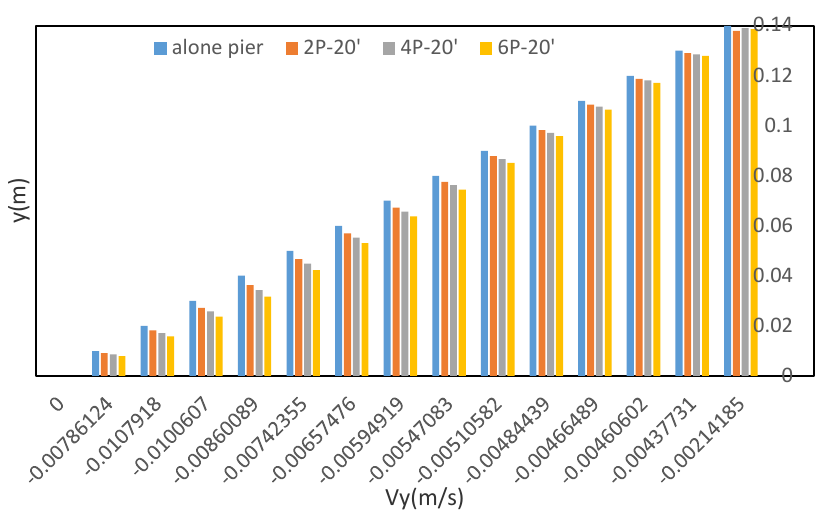
Fig 18. Comparison of the vertical velocity component for 𝛼 = 20˚ , 𝑍 = 0